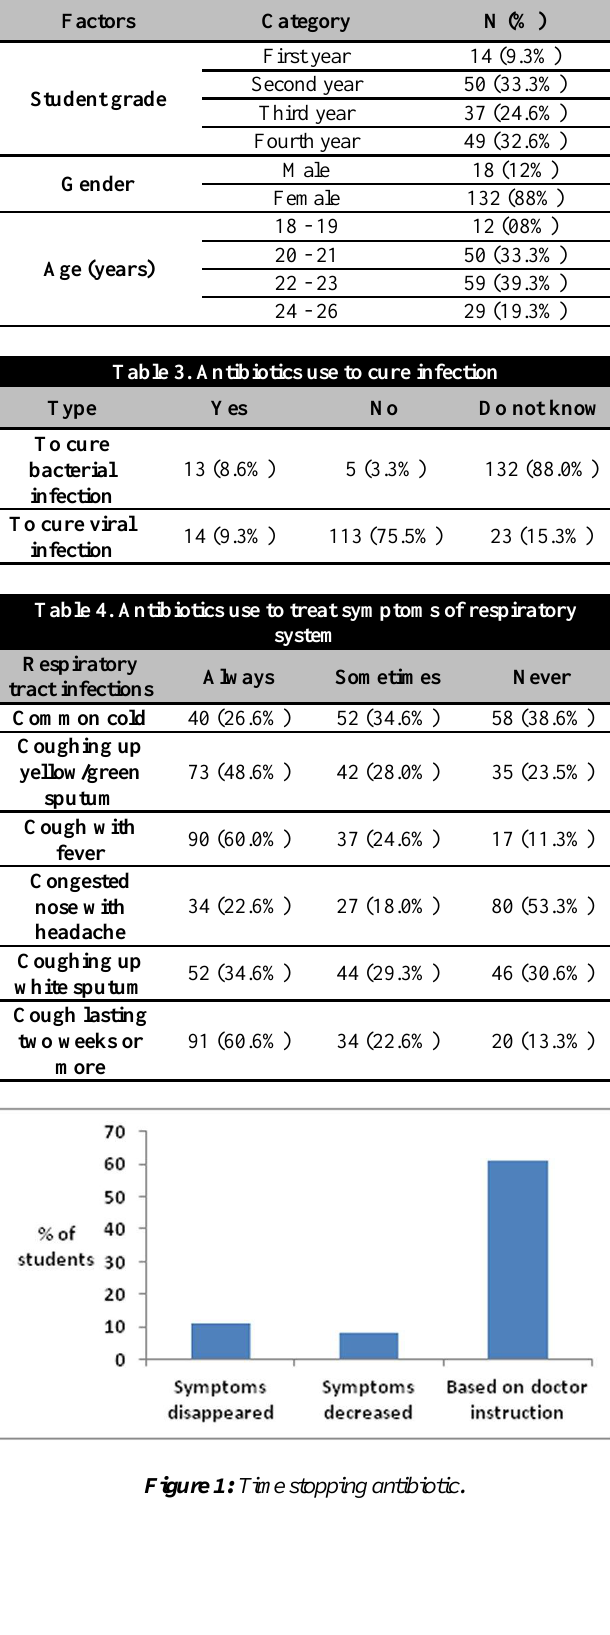
Table 2. Participants characteristics (n = 150)